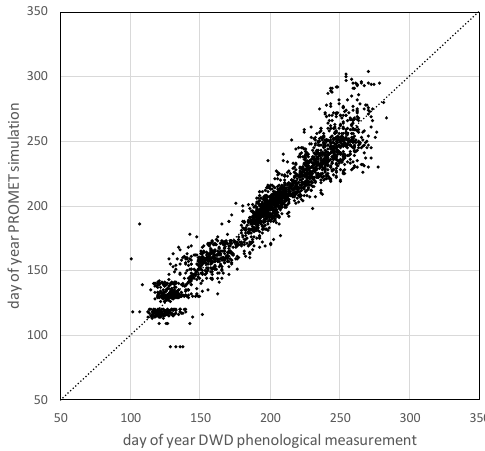
Figure 7. Simulated and measured dates (day of year DOY) of 2011 to 2014.